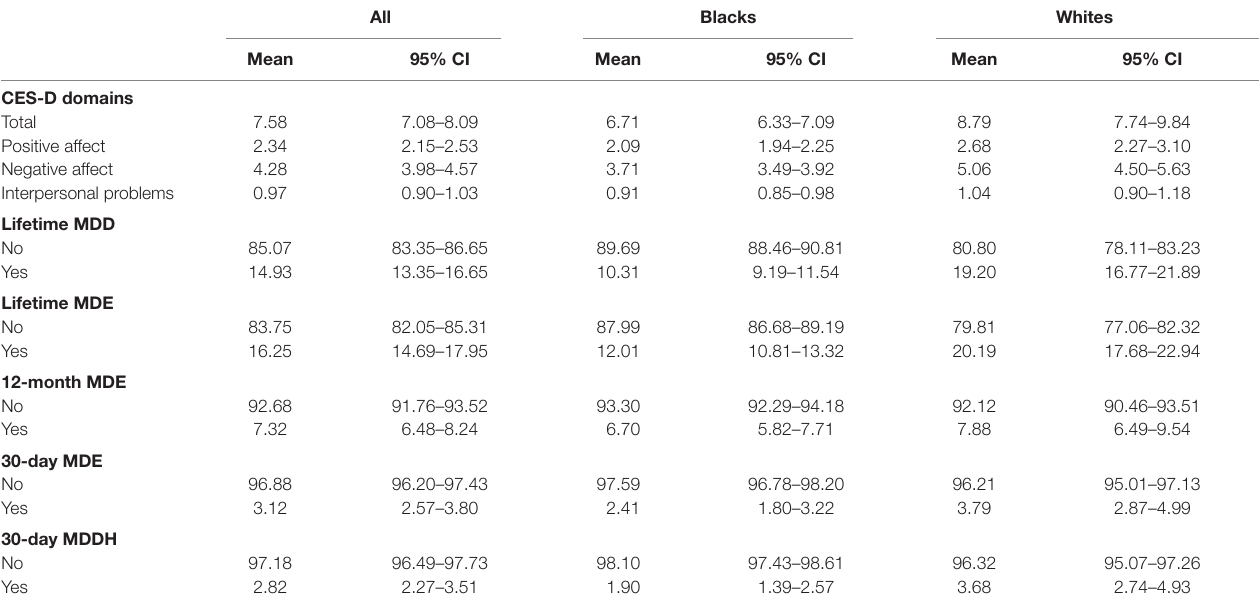
TaBle 1 | Descriptive statistics of the ces-D factors and depressive disorders based on ethnicity. all Blacks Whites